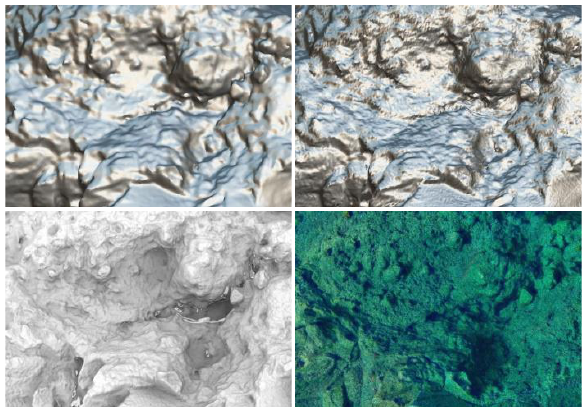
Figure 8. PBR texture maps. Upper-left : visualizations of the simplified mesh geometry without normal map; upper-right : with normal map; lower-left : ambient occlusion texture; and lower- right : final PBR render.